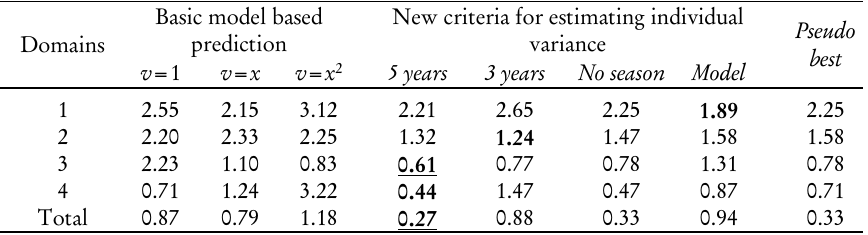
Comparison among MAPEs obtained through the use of the optimal model based predictor and different criteria for model unit variance estimation Mean of 4 quarters – 1000 random replications referred to 2010 – Estimates with post-stratification